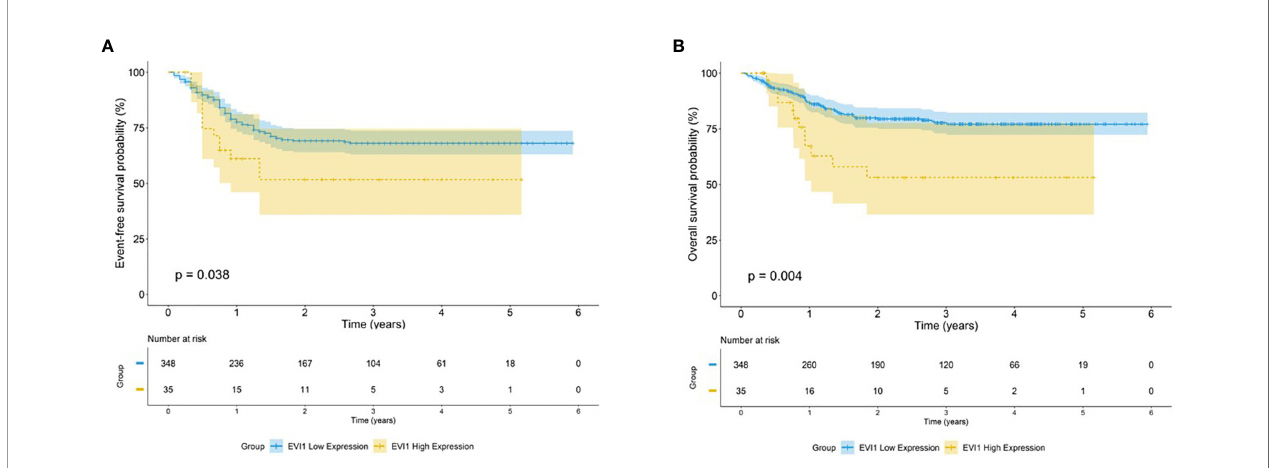
FIGURE 1 | Survival outcome for high EVI1 expression in pediatric AML. Kaplan – Meier curve estimates for the (A) EFS and (B) OS in the total cohort between EVI1 high and EVI1 low